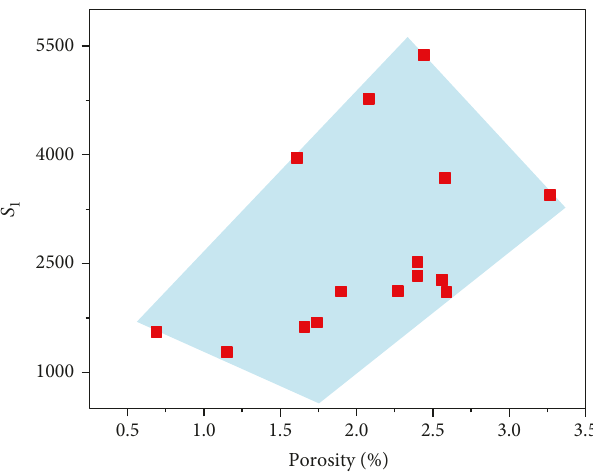
S 1 and porosity. 1 is the area under the